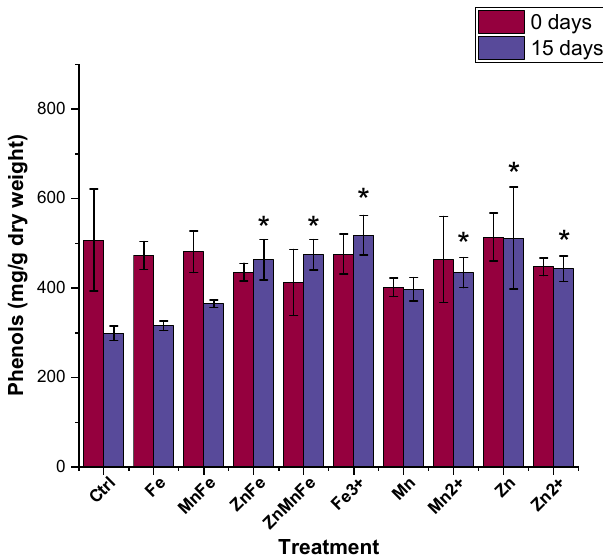
Figure 8. Total phenolic compounds content of tomato fruits stored at room temperature for 0 and 15 days after treatment with either Fe 3 O 4 (Fe), MnFe 2 O 4 (MnFe), ZnFe 2 O 4 (ZnFe), Zn 0.5 Mn 0.5 Fe 2 O 4 (ZnMnFe), Mn 3 O 4 (Mn), ZnO (Zn), or their ionic counterparts; n = 4; * denotes statistical difference between control and treatments.